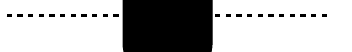
Figure 12 . There are no non-zero loop corrections to the h (cid:30) q (cid:30) q i propagator. of either advanced or retarded propagators, and this vanishes, meaning that there are no perturbative loop corrections to h (cid:30) q (cid:30) q i